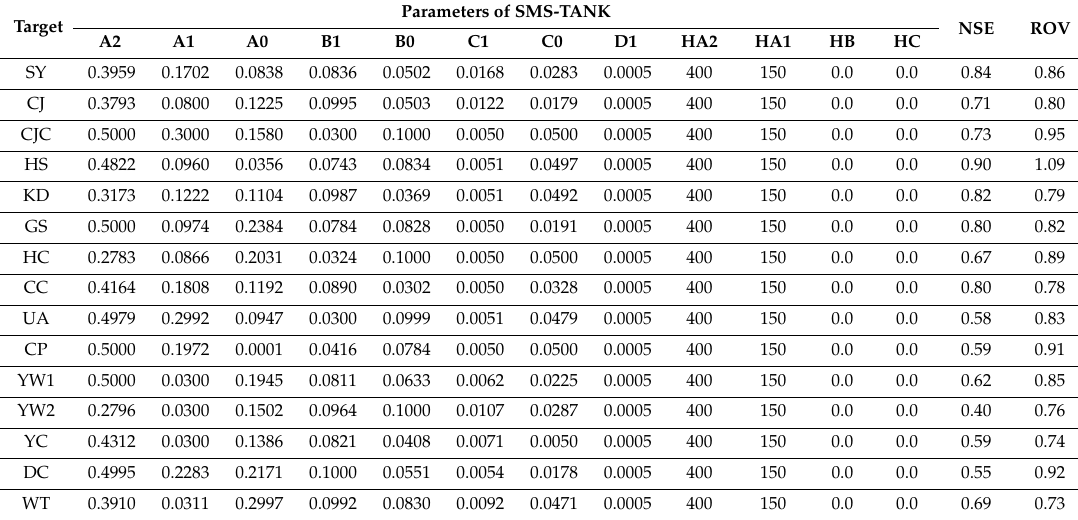
Table 7. Nash–Sutcli ff e E ffi ciency (NSE) and Ratio of Volume (ROV) between the predicted and actual amounts for the same spots as in Table